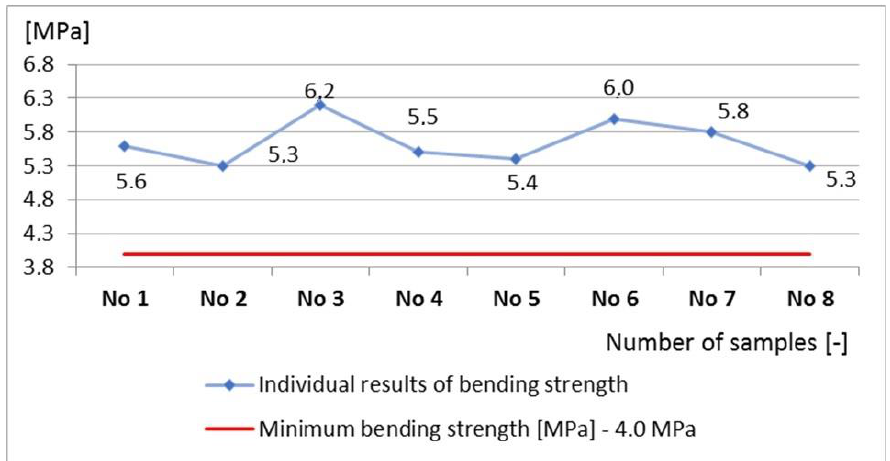
Figure 18. Bending strength v alues of the tested curbs.